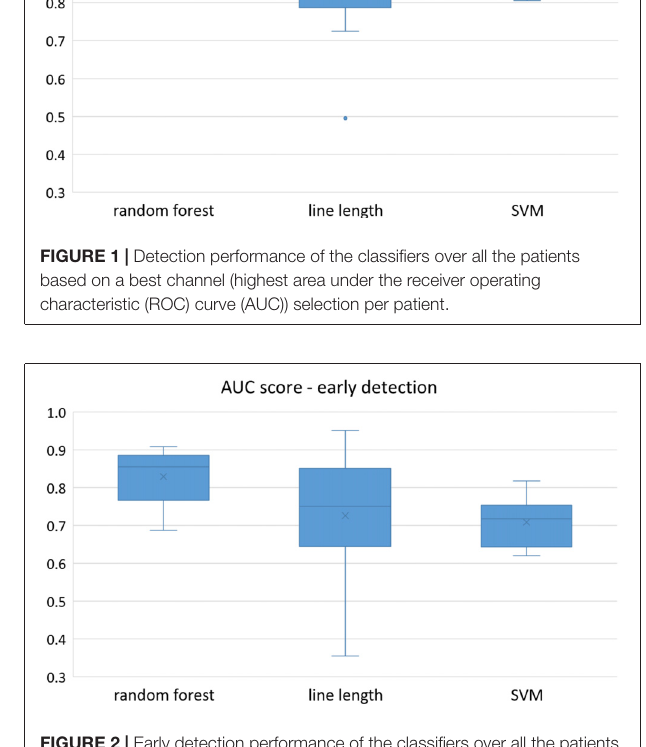
FIGURE 2 | Early detection performance of the classifiers over all the patients based on a best channel (highest AUC) selection per patient. Here, just the seizures which could be detected in the first 10 s are counted as a true positive.